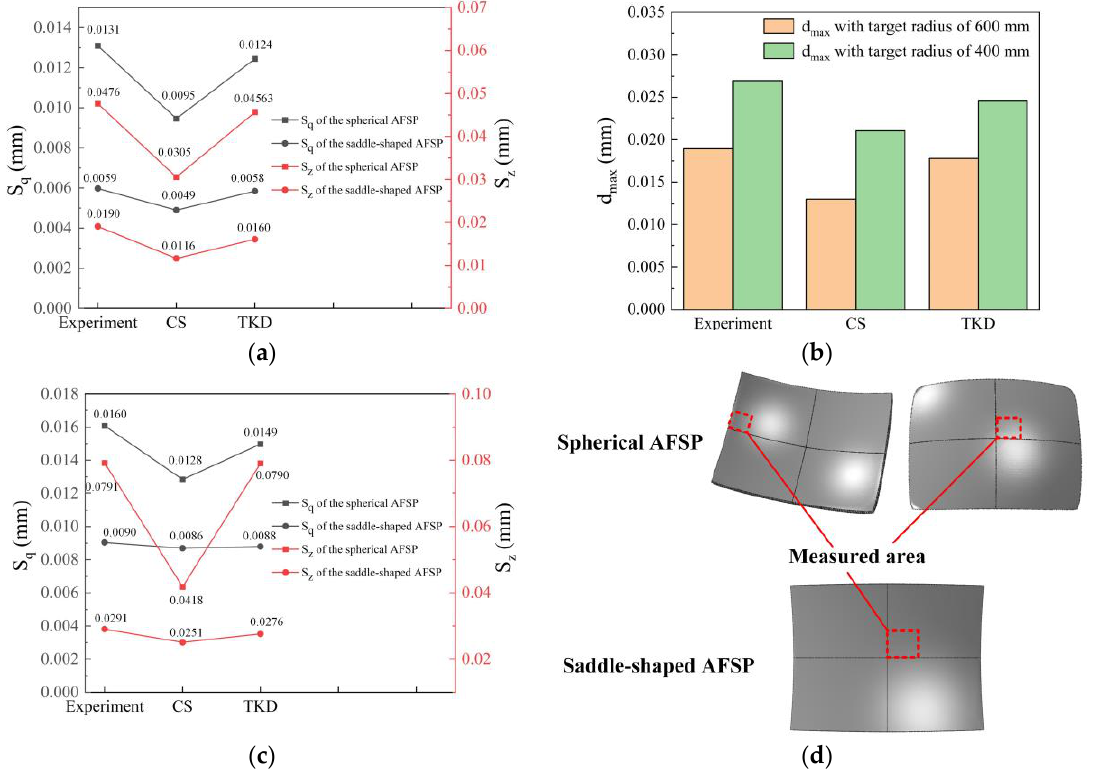
S of AFSP with spherical and saddle-shaped target radius of 600 mm ( b ) Figure 11. ( a ) S and z q d of AFSP with spherical target radii of 600 mm and 400 mm ( c ) max spherical and saddle-shaped target radius of 400 mm ( d ) Measurement area obtained by surface quality evaluation parameters. evaluation